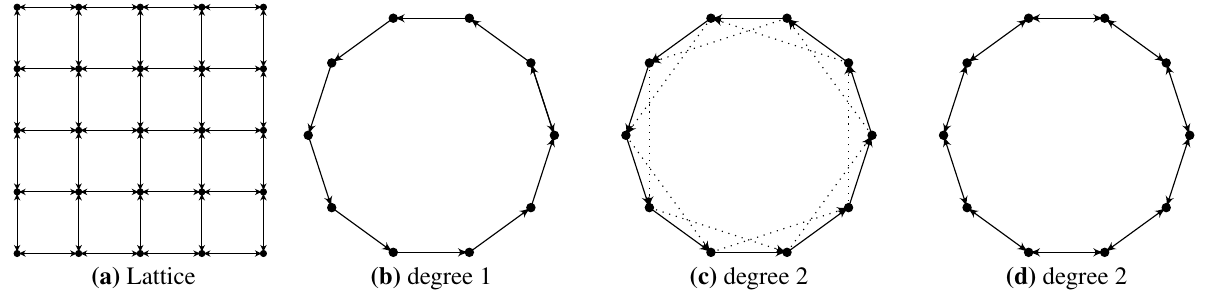
Figure 1. Lattice and circular network